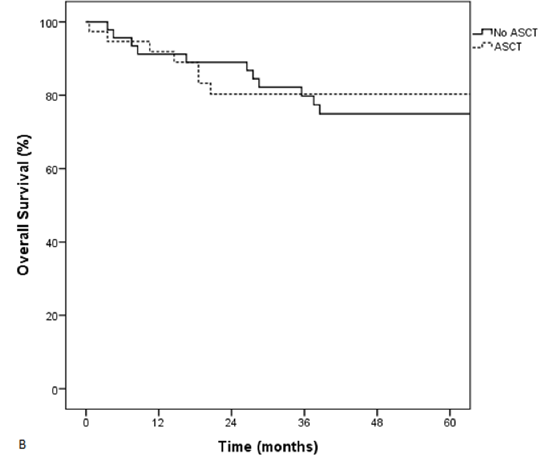
Figure 4. Progression-free survival (PFS) ( A ) and overall survival (OS) ( B ) of patients who did or did not receive autologous stem cell transplantation (ASCT) by landmark analysis.